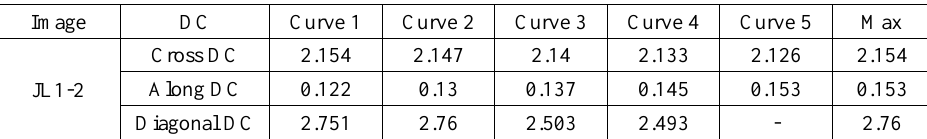
Table 2. The deviation coefficients of the projection trajectories in JL1-2. The deviation coefficients in the table have been multiplied by 10 4 .